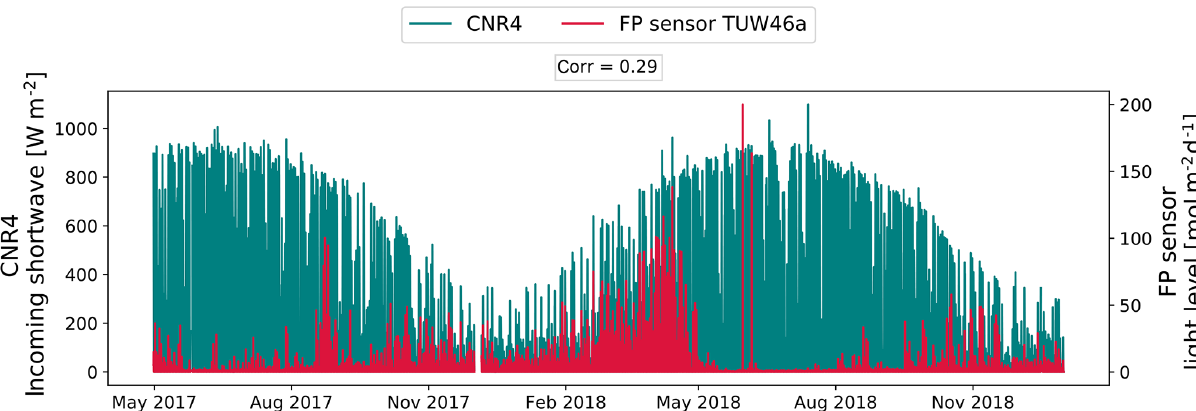
Figure 7. Same as Fig. 6, but for FP sensor TUW46a (located in sparse forest).